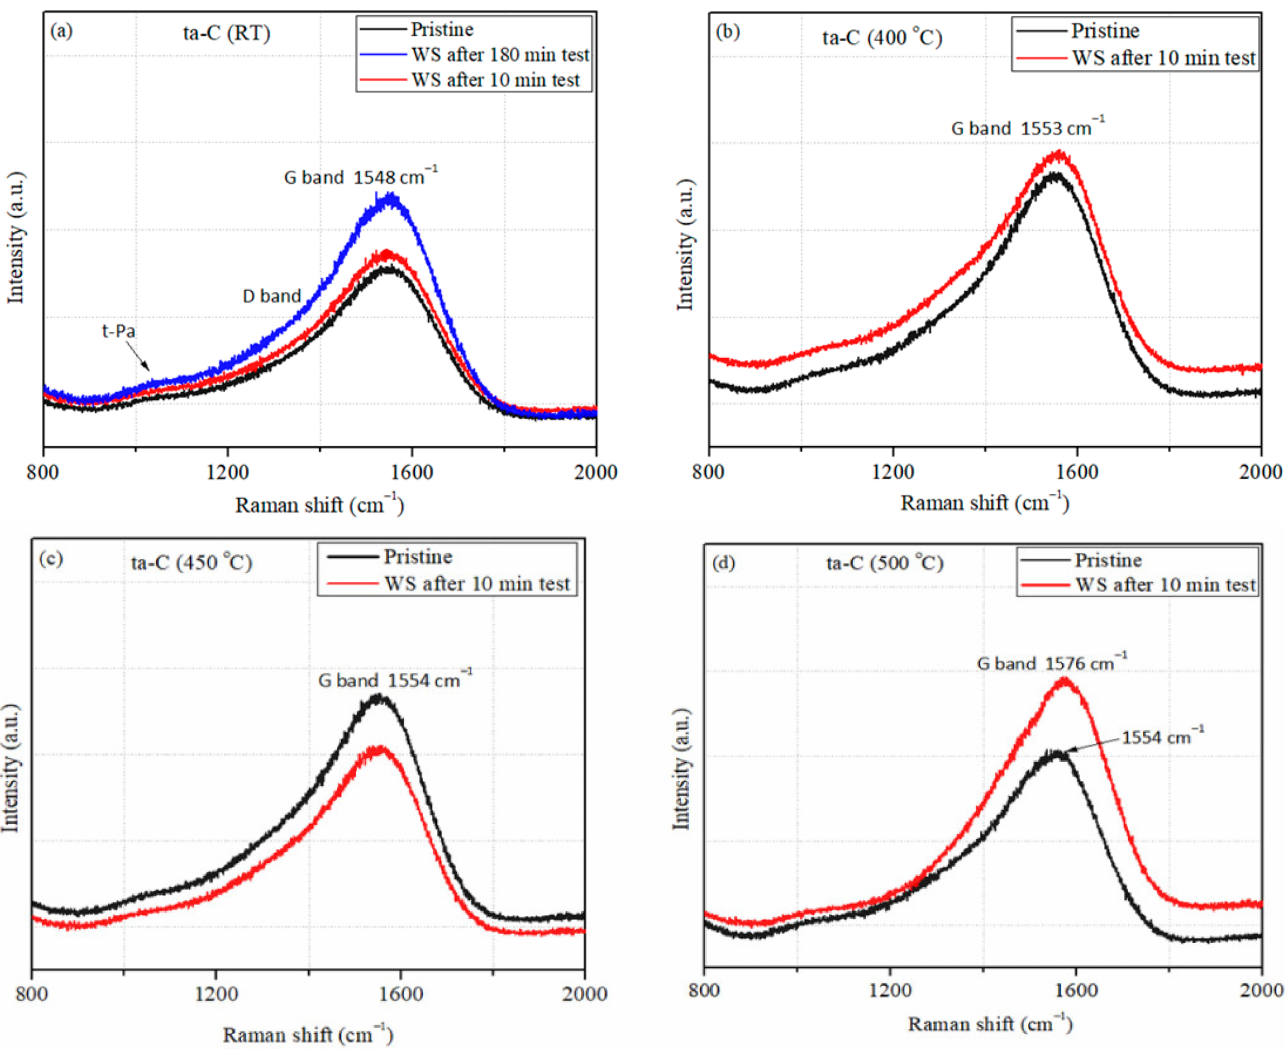
Figure 7. Raman spectra taken on the pristine and within wear scar surfaces of the ta-C coating after the sliding tests at ( a ) RT, ( b ) 400 ◦ C, ( c ) 450 ◦ C and ( d ) 500 ◦